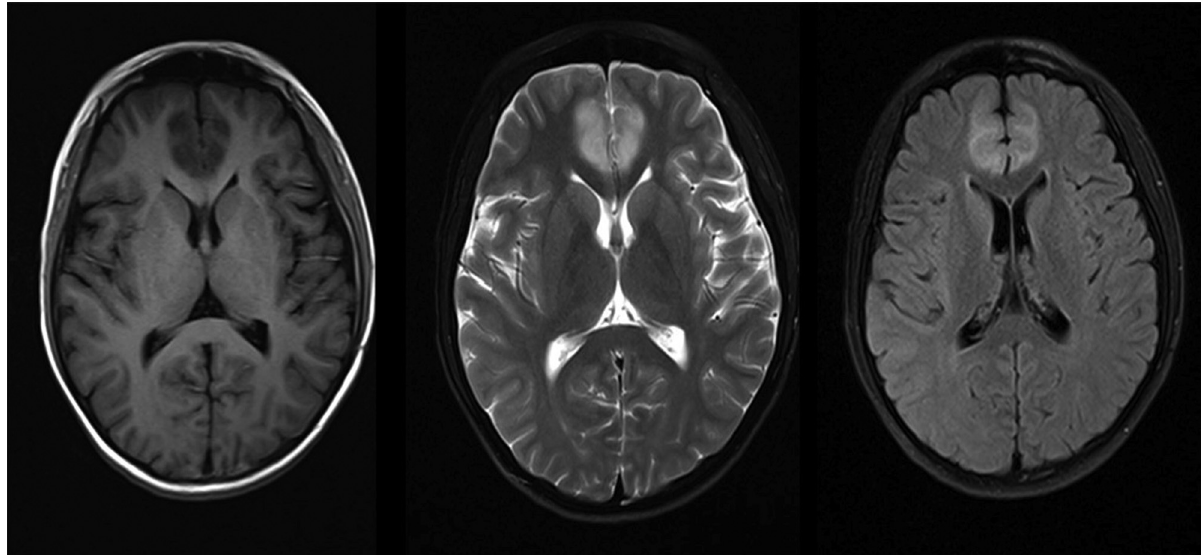
Figure 1: Brain MRI shows a region of high signal intensity in bilateral frontal lobe.